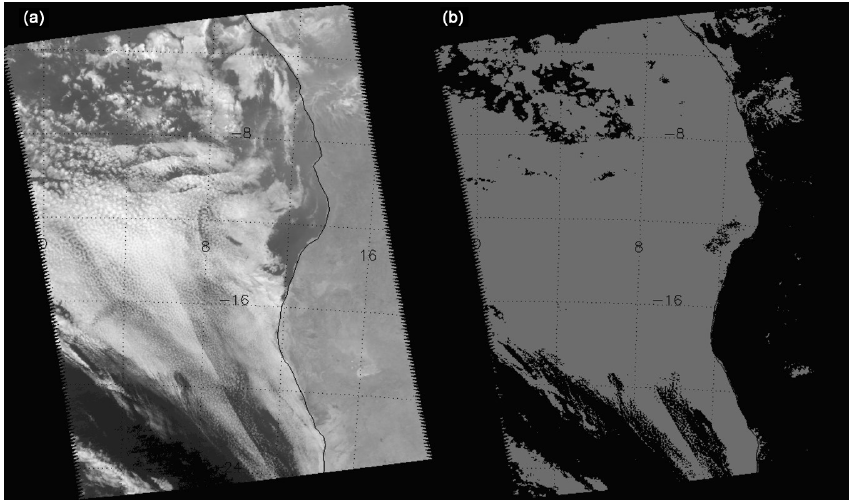
Figure 1. AIRS version 5 visible channel 4 radiance (0.49–0.94µm) at a nadir spatial resolution of 2.28km (left), and AIRS cloud mask (binary clear and cloudy) determined from visible channel thresholds (right). See Gautier et al. (2003) for more details. Table 1. The four regions investigated in this study are greatly expanded in area from Klein and Hartmann (1993). The four columns with percentages and total counts are defined at the AIRS/AMSU field-of-regard (FOR) spatial scale. The three cloudy categories indicate whether clouds of that type occur with any frequency within the AIRS/AMSU FOR. Clear sky is defined over the entire AIRS/AMSU FOR and is therefore very infrequent. Region